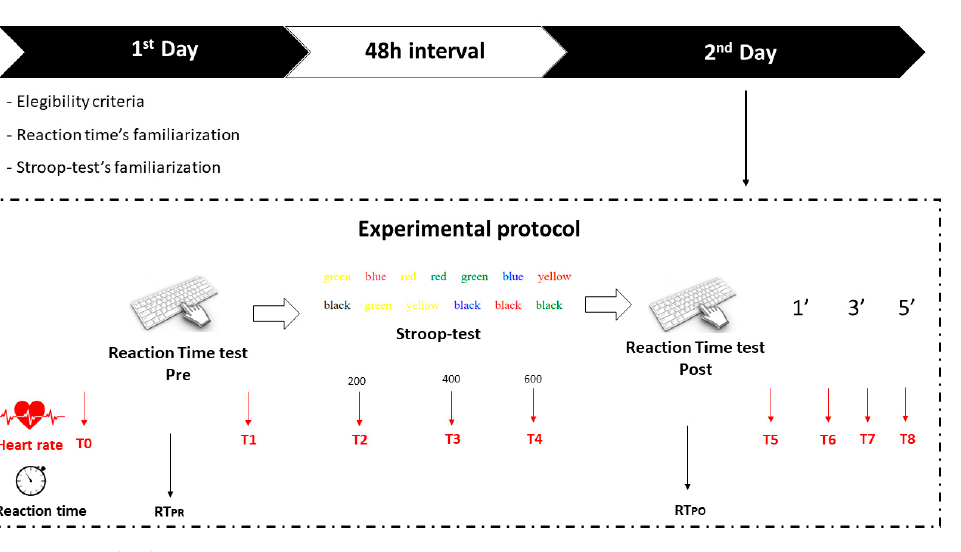
M button combined with white color Figure 2. Color modified keyboard. On the second trial, each participant took part in the test without interruptions, as follows: Reaction Test PRE → Stroop Test → Reaction Test Post → Rest 5’ The participant was instructed to keep a heart rate monitor belt for the entire dura- tion of the test to allow reading of the data in several moments of the protocol: •